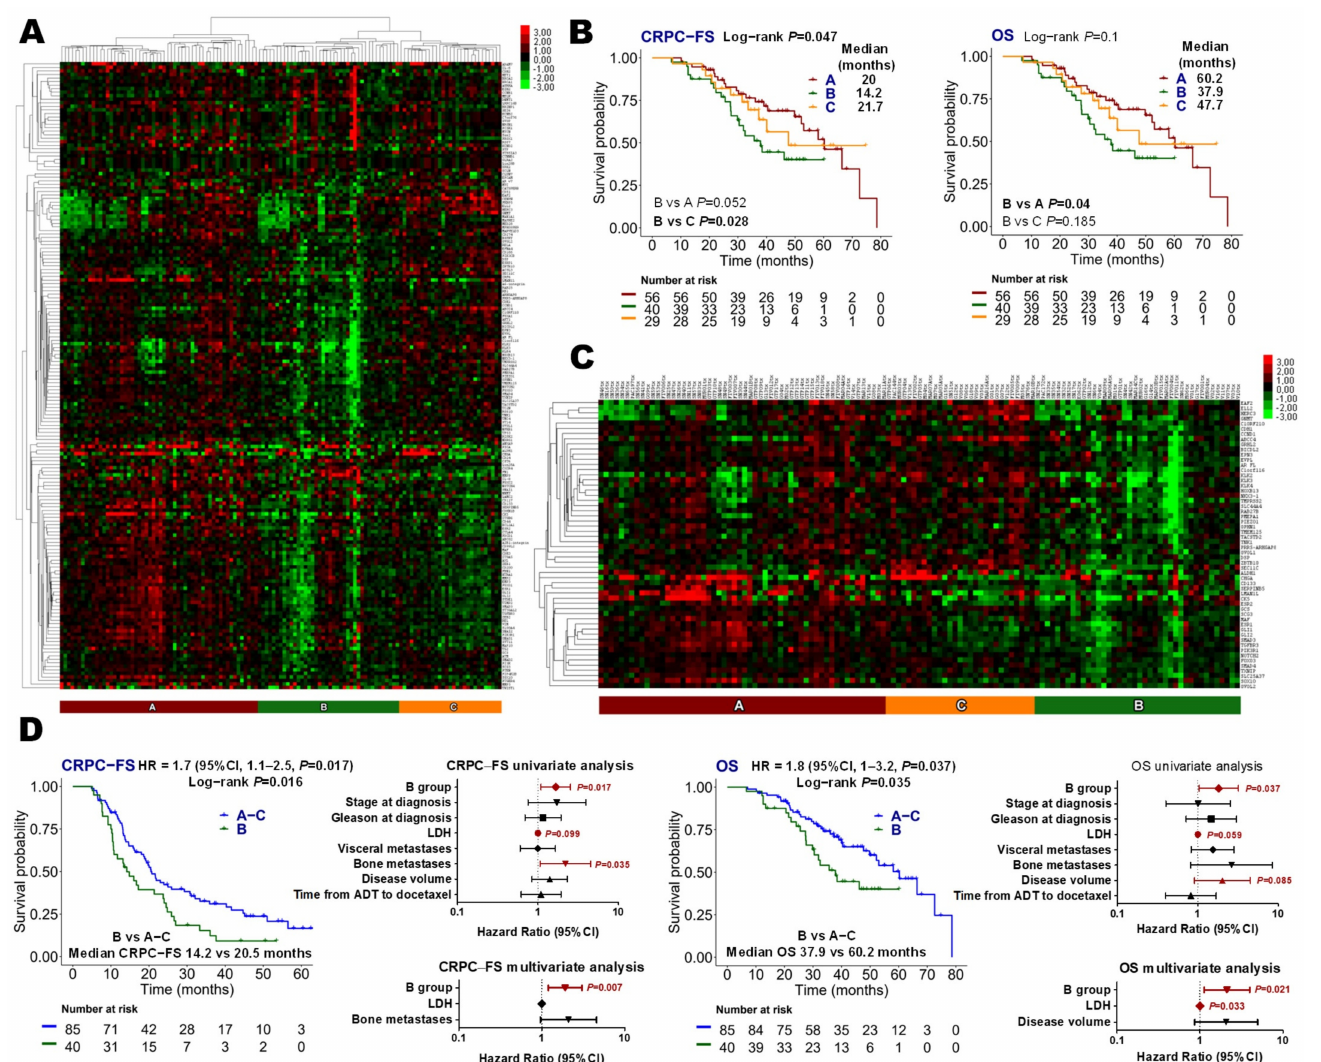
Figure 1. Global gene expression analysis. ( A ) Hierarchical clustering expression heatmap for expression values of the global genes panel, excluding TMPRSS2-ERG -specific and imbalance probes; ( B ) Kaplan– Meier curves representing CRPC-free survival (CRPC-FS) and overall survival (OS) according to groups defined from the global genes panel; ( C ) hierarchical clustering expression heatmap for expression values of differentially expressed genes in group B vs. groups A–C (|FC| ≥ 1.5 and FDR < 0.05); ( D ) Kaplan–Meier curves representing CRPC-FS and OS according to group B and groups A–C and forest plots representing the univariate and multivariate analysis. LDH: lactate dehydrogenase; HR: hazard ratio; CI, confidence